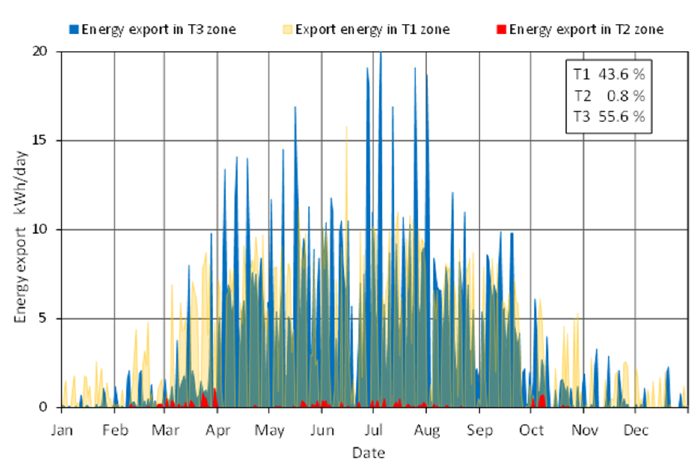
Figure 6. Energy imported in 2020.